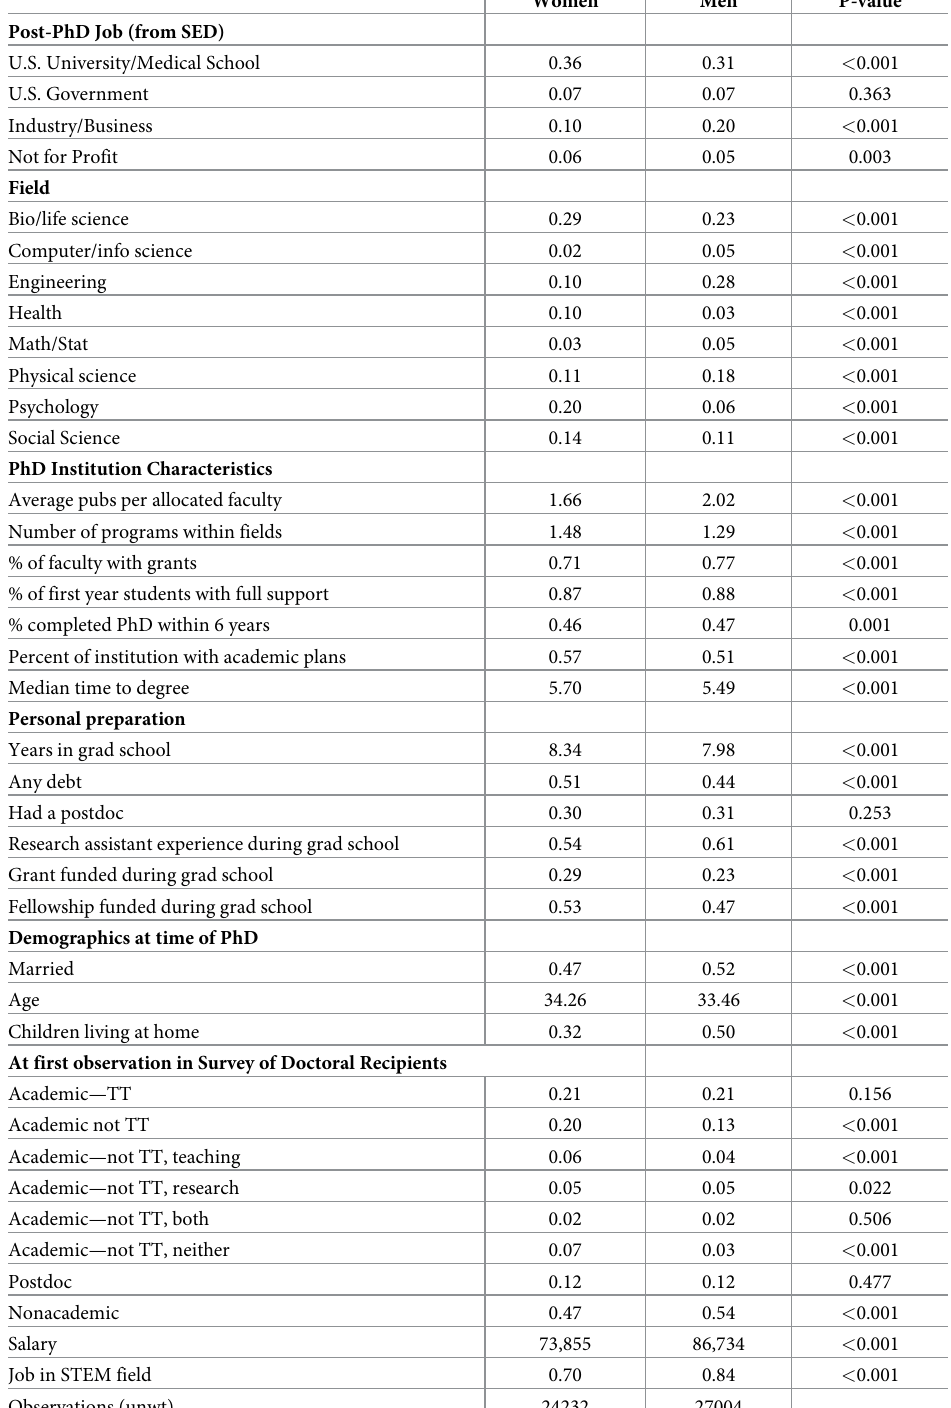
Table 1. Comparison of characteristics at the time of PhD between all men and